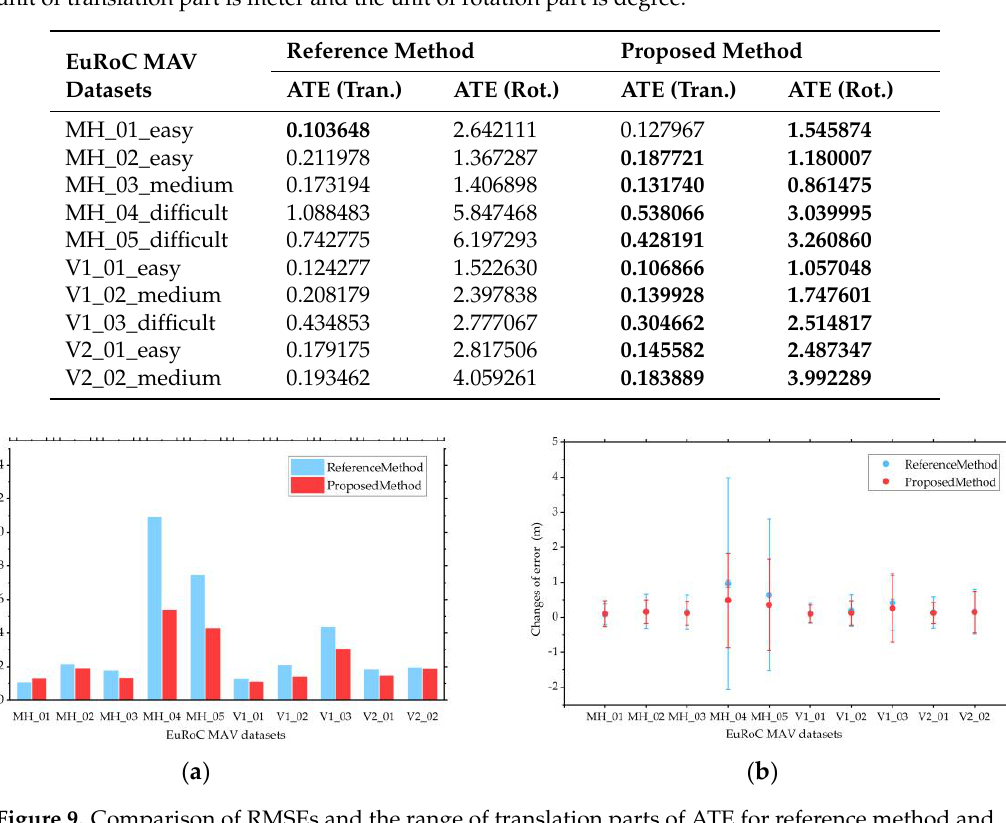
Figure 9. Comparison of RMSEs and the range of translation parts of ATE for reference method and our proposed method using the EuRoC MAV datasets. ( a ) RMSEs of reference method (blue) and our proposed method (red); ( b ) The range of translation parts of ATE of the two methods. The three points on each error bar from top to bottom are the maximum ATE error, average ATE error, and minimum ATE error respectively.